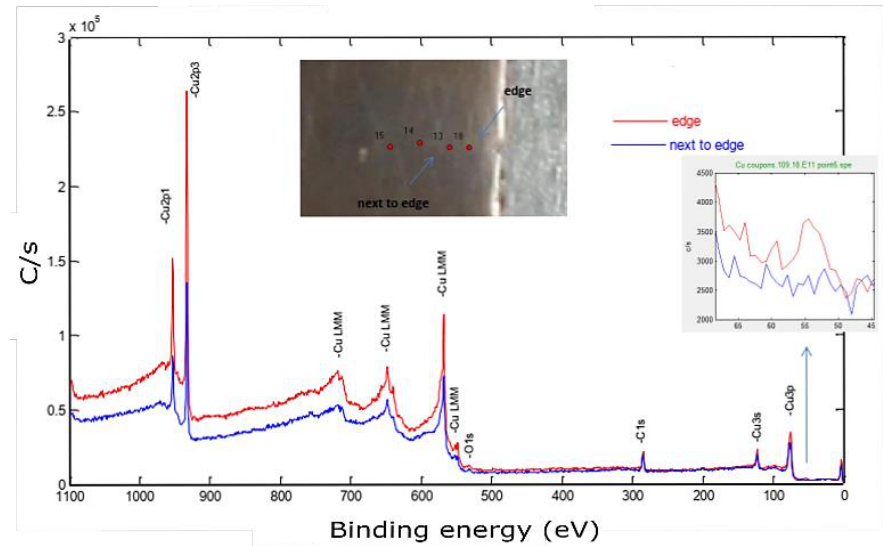
Figure 16. X-ray photoelectron spectroscopy of the Cu sample built by L-PBF ( P = 370 W, v = 500 mm/s, h = 0.1 mm). The inset shows a zoom of the Fe3p peak. This spectrum was used to identify the impurities in the current sample and specified the quantification regions, which were the doublet peaks of Cu 2p and Fe 3p (because there was a strong overlapping between CuLMM and Fe 2p), C 1s, and O 1s. To track the amount of diffused elements, four equally spaced points were investigated along this zone, as shown in the in situ image of the inspected sample. The next step aimed to determine the atomic concentration of the constitutional elements using the peak areas under high-resolution spectra. The relative sensitivity factor (RSF), stated by Scofield, was utilized to scale the calculated peak area [38]. Figure 17 shows a weight concentration of the impurities along the building direction.